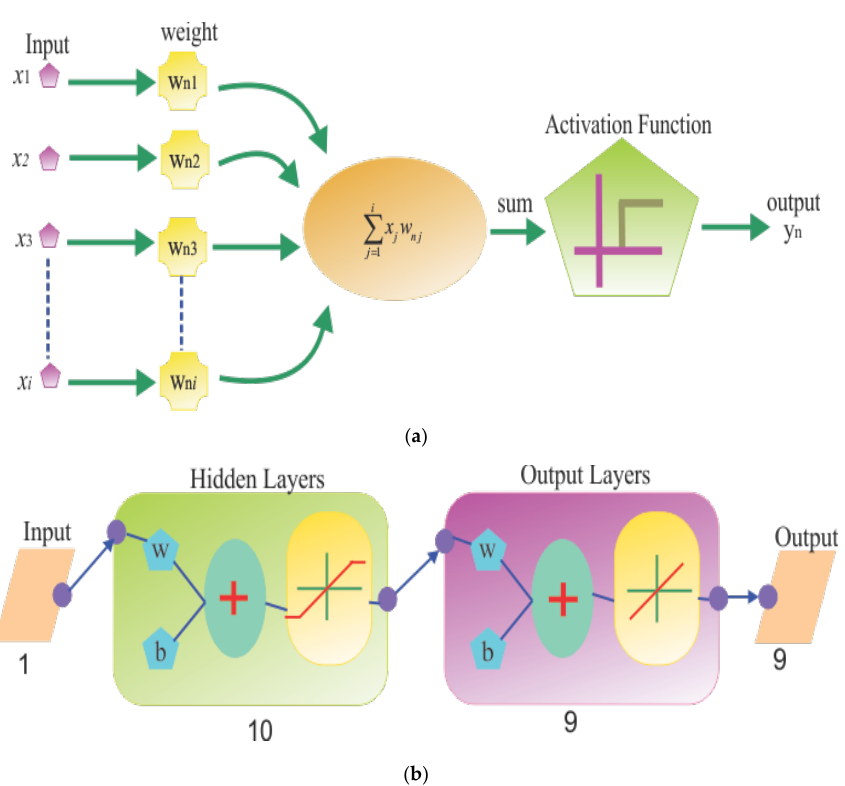
Figure 9. ( a ) A model configuration for singular neural network ( b ) Design of a planned neural network.